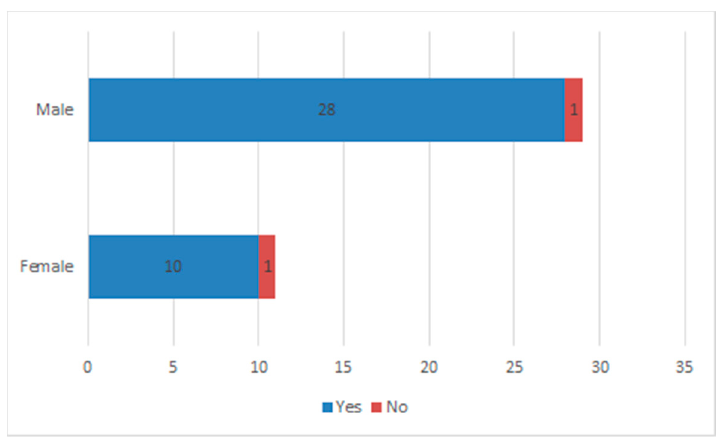
Figure 7. Number of students’ responses about acquiring the required HCI skills by gender.